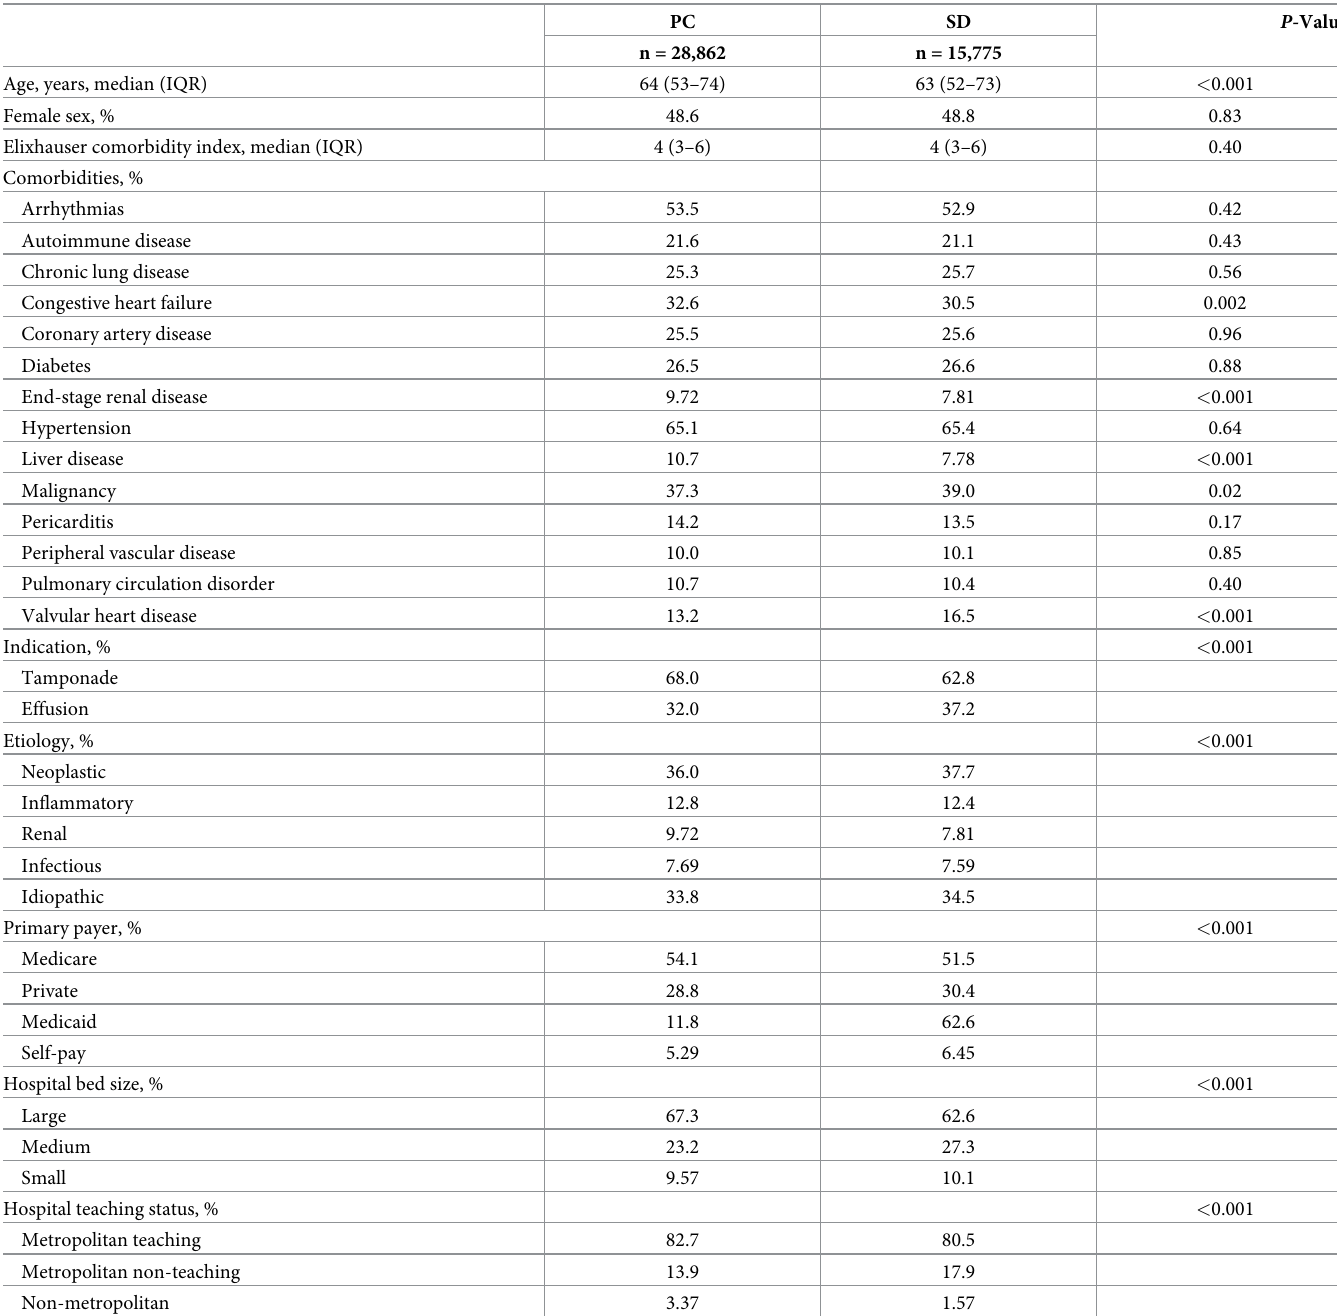
Table 1. Patient and hospital